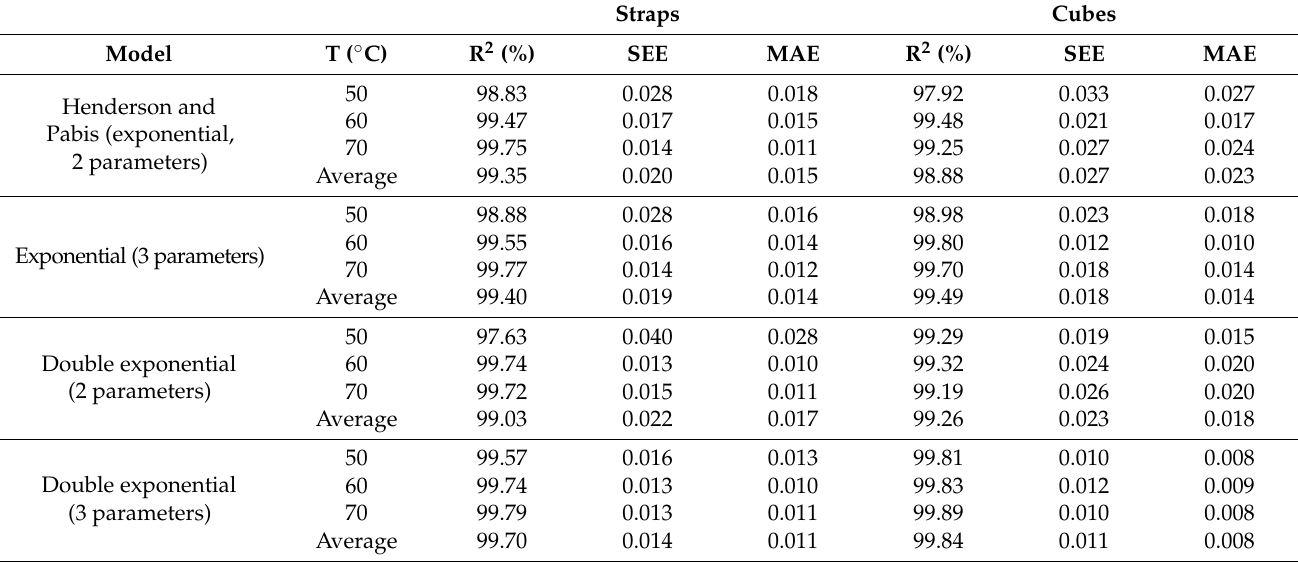
Table A1. Determination coefficients and adjustment errors of the different drying models